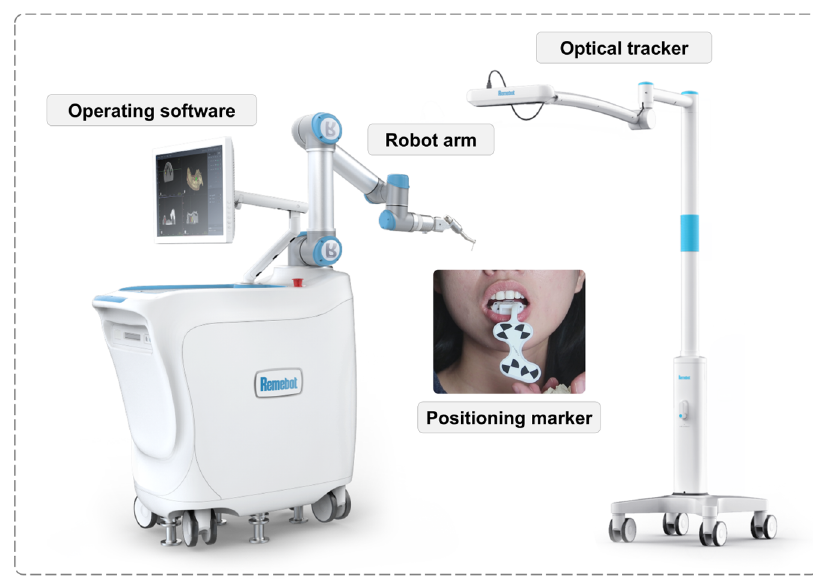
Figure 1. Initial dental status and its panoramic radiograph.